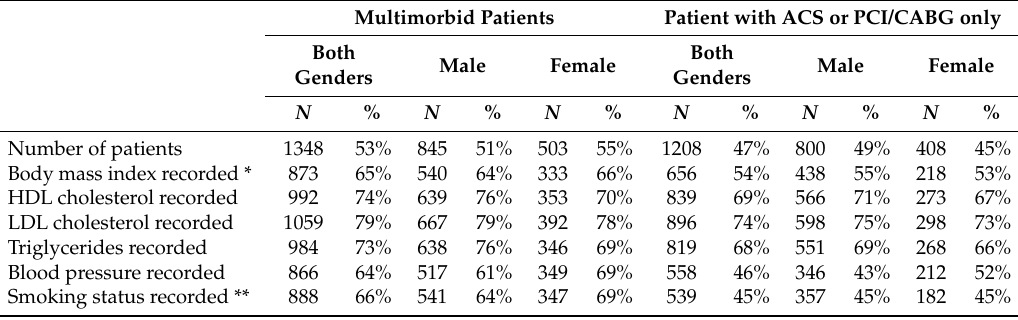
Table 1. Performed coronary heart disease risk factor measurements and recordings of multimorbid and non-multimorbid patients with ACS or PCI/CABC in North Karelia Hospital District catchment area in